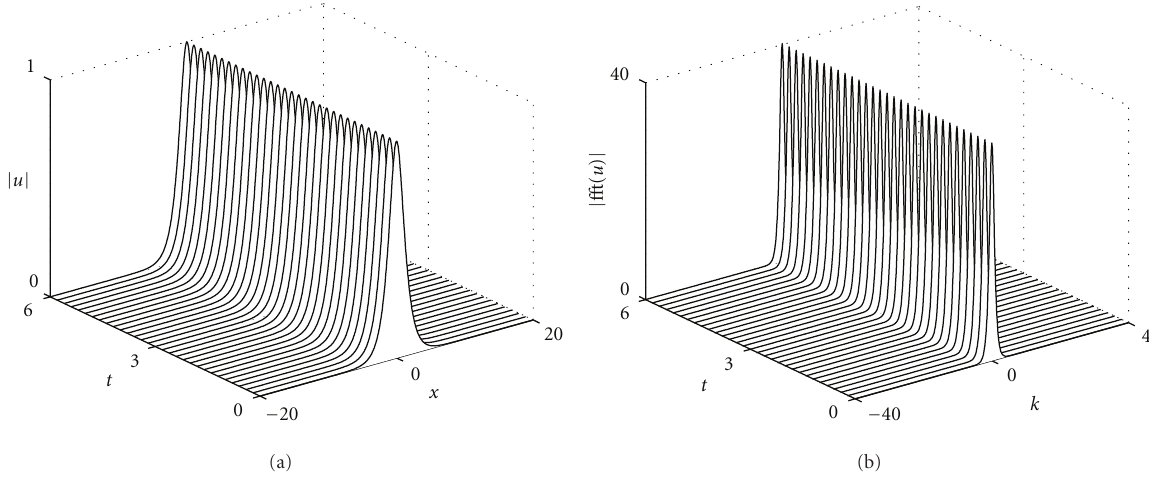
Figure 1: Evolution of the N = 1 soliton. Although it appears to be a very simple evolution, the phase is evolving in a nonlinear fashion, and approximately 50 Fourier modes are required to model accurately this